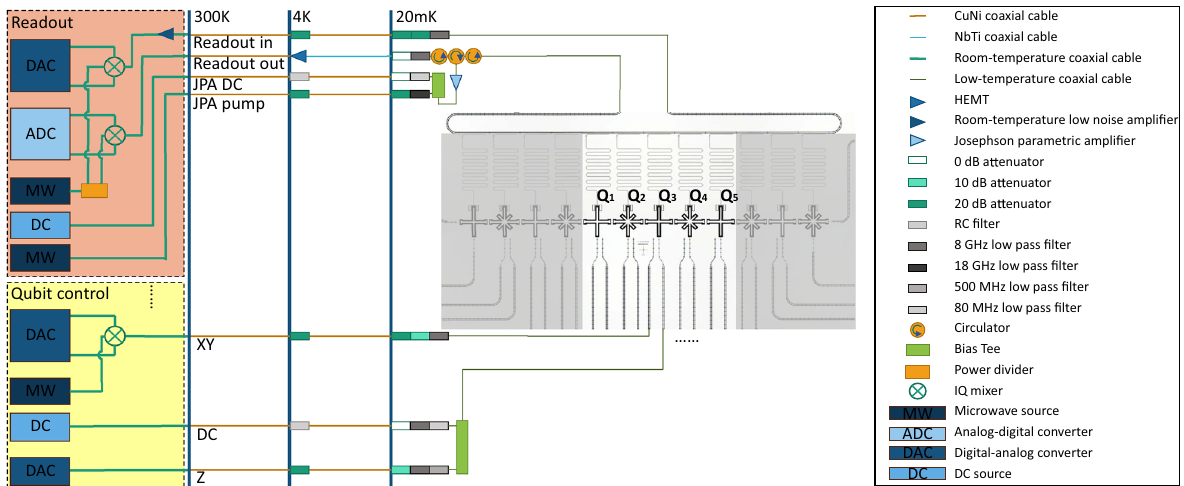
Fig. 5 Experimental wiring setup and false colored optical image of the qubit device. There are fi ve adjacent qubits used in this experiment. To perform the state manipulation and detection, fi ve sets of qubit control and one set of readout units are used. For the control of each qubit, there are one microwave (XY) control and one fl ux bias. We use two digital-analog converter (DAC) channels and one microwave source to modulate the control signal via an IQ mixer. The XY signal is then wire-bonded to the XY control line, which is capacitively coupled to the qubit. The low speed and high-speed bias (Z) signal is generated by a DC source and a DAC channel, and then combined together at the mixing chamber (MXC) plate via a bias-Tee. The Z signal is also wire-bonded to the Z control line, which is inductively coupled to the qubit. For state detection, the readout signal is modulated by two DAC channels and one microwave source via an IQ mixer. The signal is attenuated for 60 dB and then connected to the transmission line of the device. Then, the readout signal goes to the array of circulators. On the second circulator, the signal is ampli fi ed by the Josephson parametric ampli fi er (JPA), which is biased by the DC source and driven by the microwave source. The readout signal is then ampli fi ed by a HEMT at the 4K plate and a low-noise ampli fi er at room temperature, and fi nally demodulated by an IQ mixer and captured by the analog-digital converter (ADC). We use frequency multiplexing method to simultaneously readout the states of all qubits. All room temperature electronic instruments are controlled by a computer via 1Gb Ethernet.